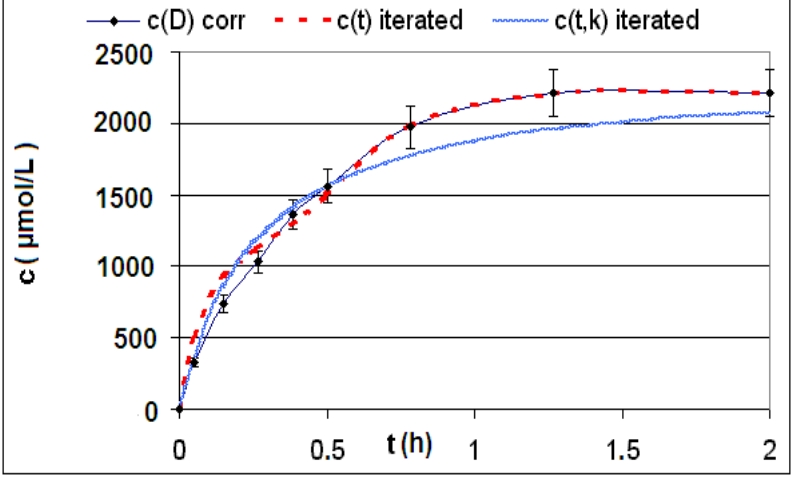
( t ) /c ( t ) /c ( t,k ) only for product P. corr iterated iterated